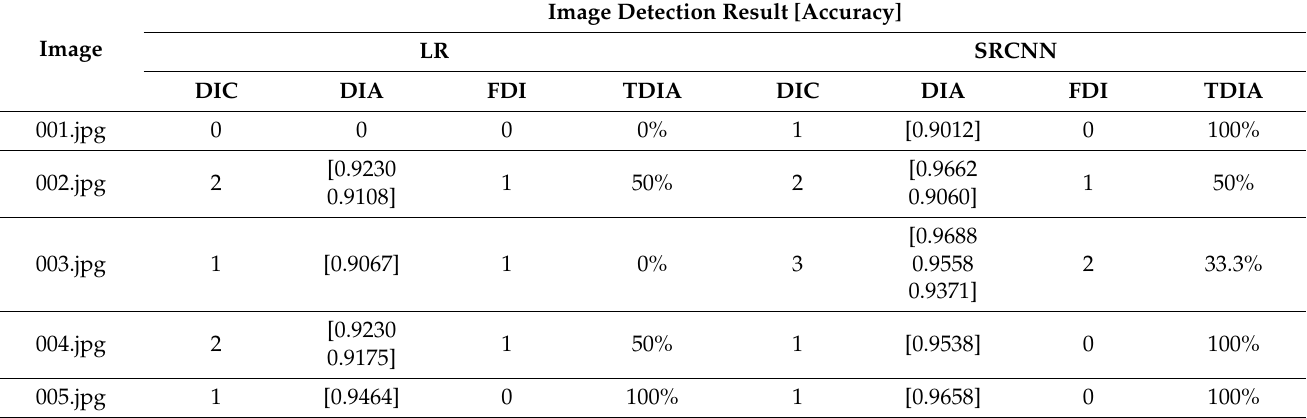
Table 5. Bridge damaged-object-detection result.